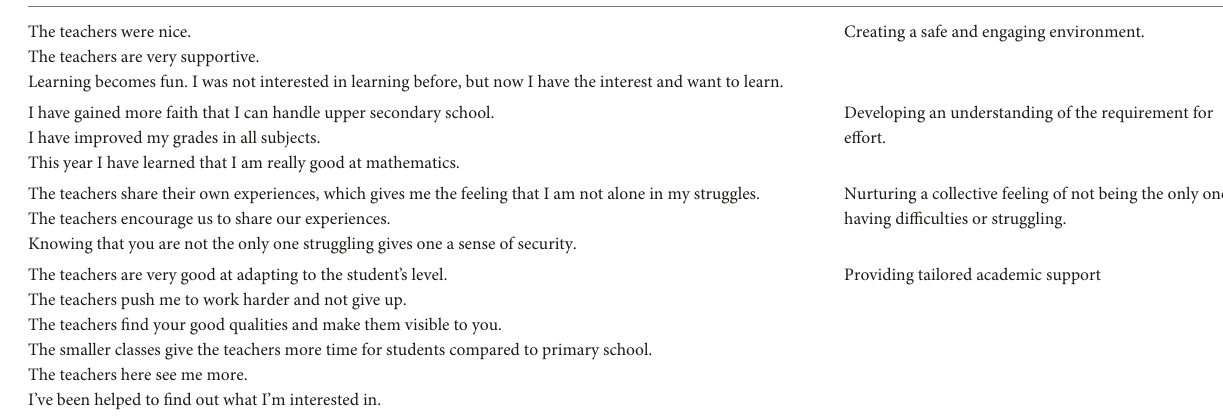
TABLE 2 Examples of the